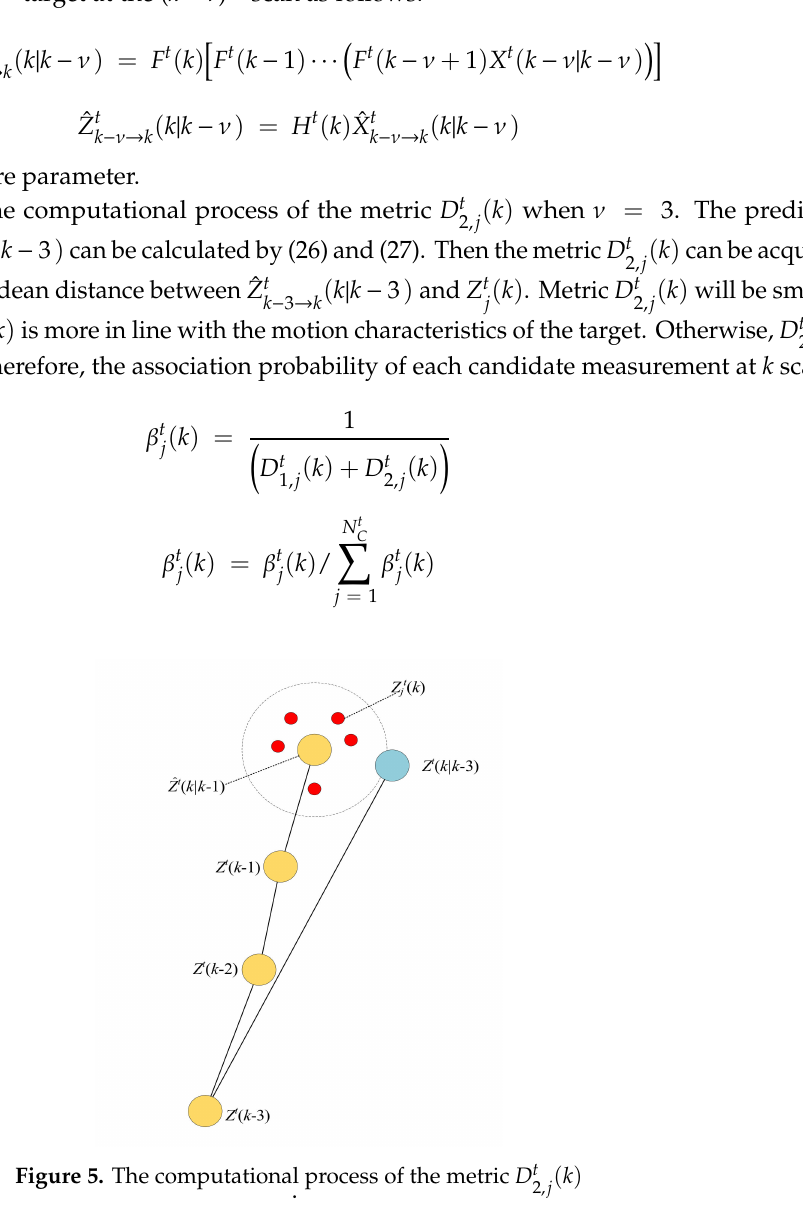
Figure 5. The computational process of the metric D t